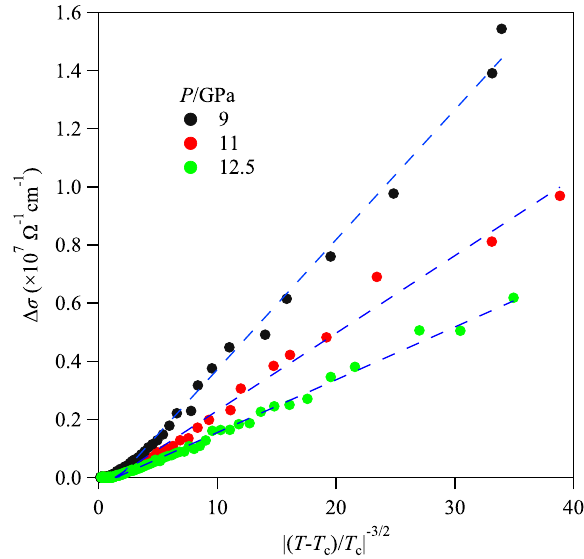
Fig. 8 Analysis with the Aslamazov and Larkin (A-L) model. The reduced temperature dependence of excess conductivity around T c along the a